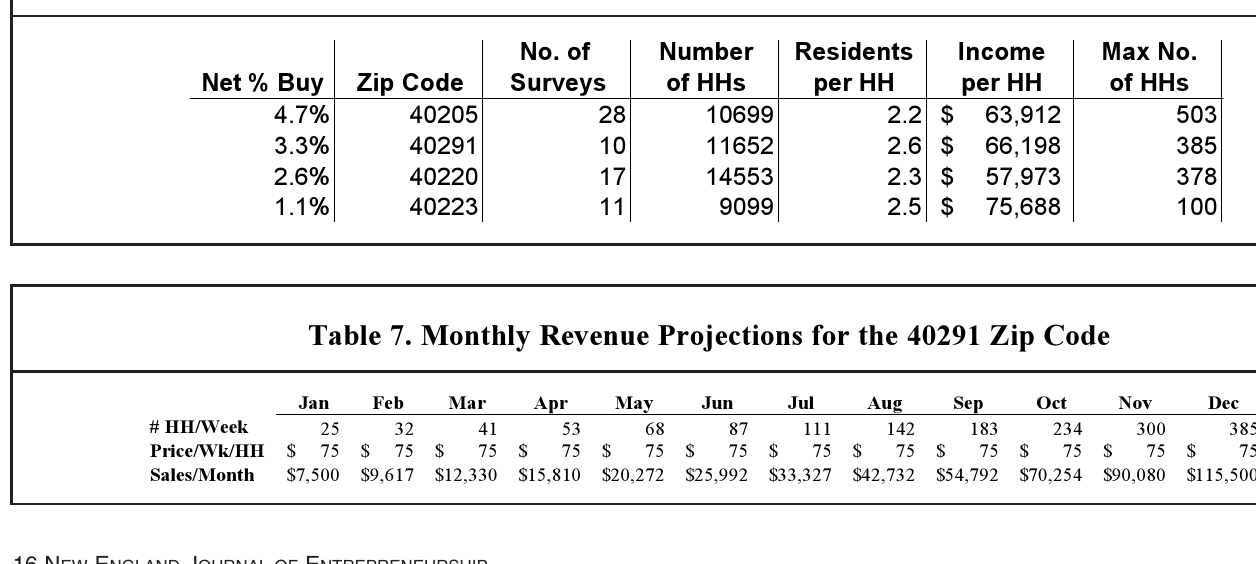
Table 6. Top Four Market Opportunities for YPC with Household Census Data